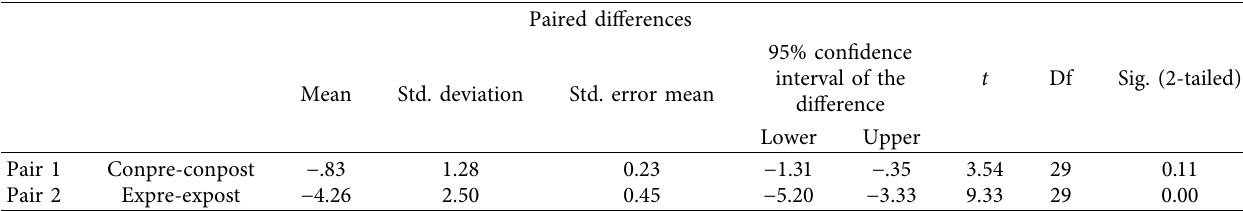
Table 15: Paired samples statistics of the experimental and control groups in the speaking pre- and posttests.